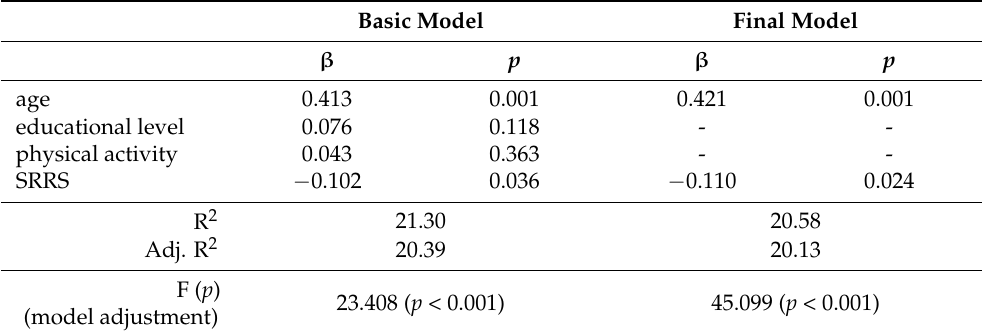
Table 5. Results of backward stepwise regression (basic and final models)—BFP as the determined variable, age, educational level, physical activity and SRRS as the determining variables.